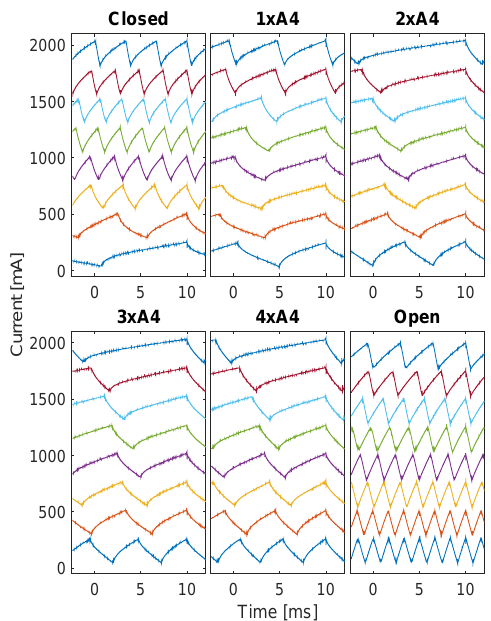
Figure 12. Current wave shapes for eight different bias currents and six different air-gaps, each separated by one piece of plain A4 paper. Measurements are averaged over 128 samples. Triggering was aligned against the 10ms peak for each sample. Note that these data were obtained using a normal hysteresis control (not hybrid switching), as this was found to be the best method to showcase the distortions of the current waveform.